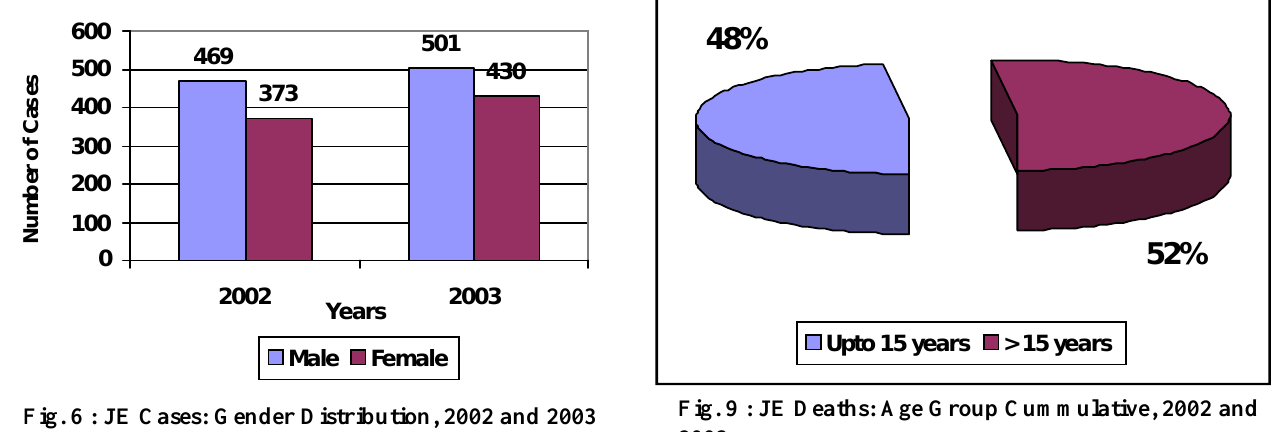
Fig. 6 : JE Cases: Gender Distribution, 2002 and 2003